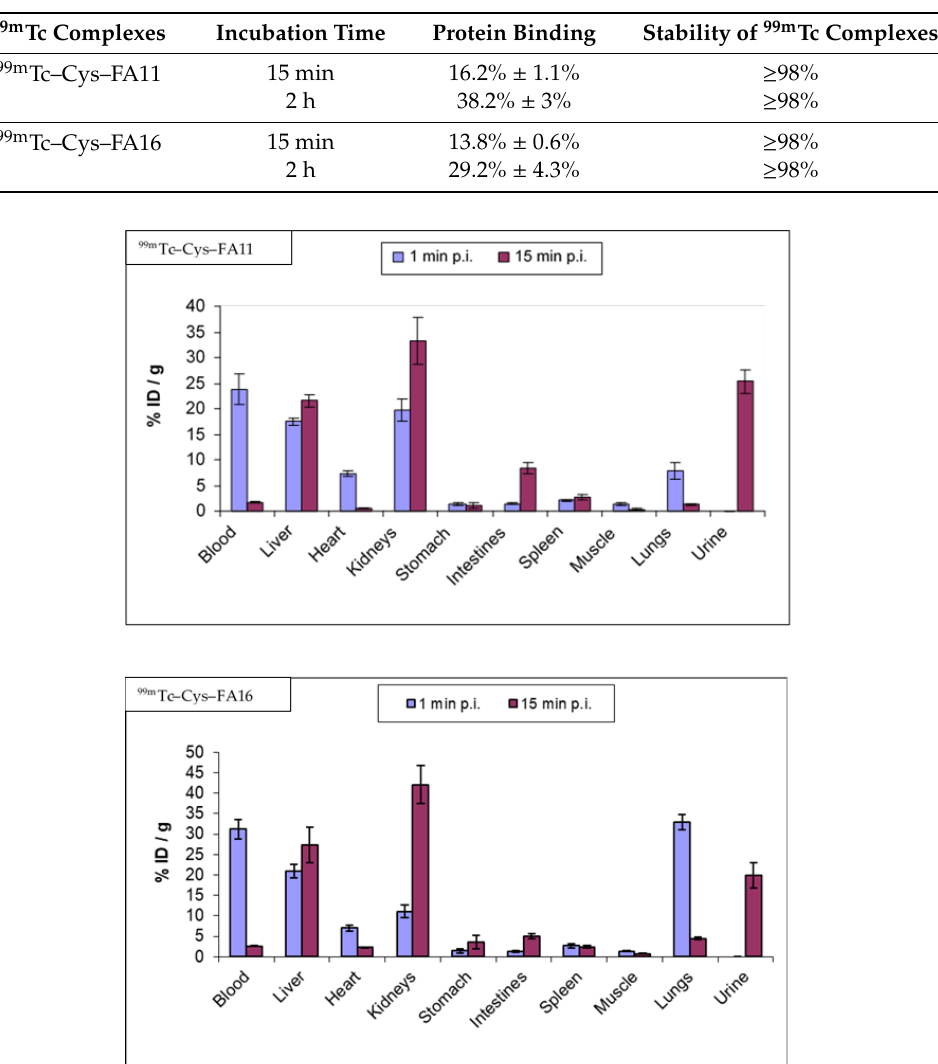
Figure 2. Biodistribution of radioactivity after intravenous injection of 99m Tc–Cys–FA11 and 99m Tc– Cys–FA16 in